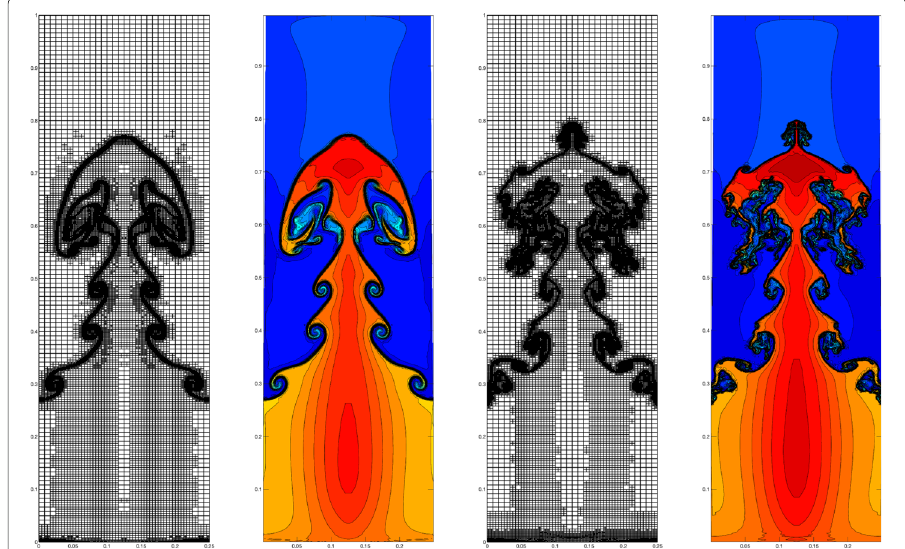
Fig. 17 Euler simulations for Rayleigh-Taylor instability without TVB limiter. From left to right: adaptive mesh for P 1 element; 30 equally spaced density contours from 0.6548 to 2.4582 for P 1 element; adaptive mesh for P 2 element; 30 equally spaced density contours from 0.6852 to 2.3728 for P 2